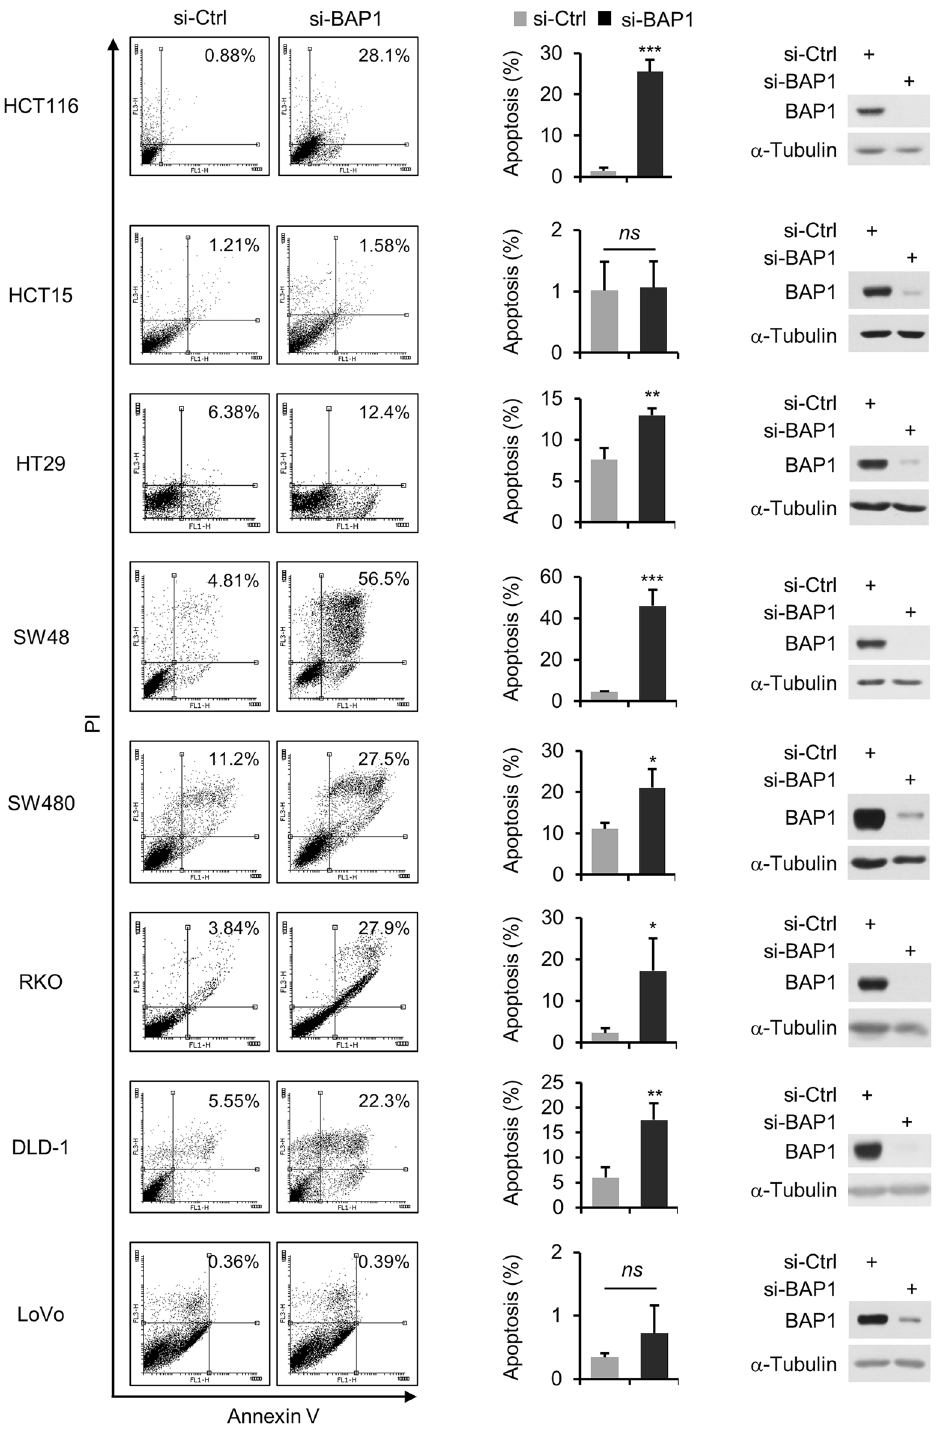
Figure 3. BAP1 depletion increases apoptosis in colon cancer cells. Results of the apoptosis assay in colon cancer cells. After transfection with control or BAP1 siRNAs, cells were subjected to Annexin V/PI double staining followed by FACS analysis. Representative results are shown (left), along with summary graphs (middle, n = 3; error bars, mean ± s.d. values) and the results of immunoblot analysis for BAP1 knockdown